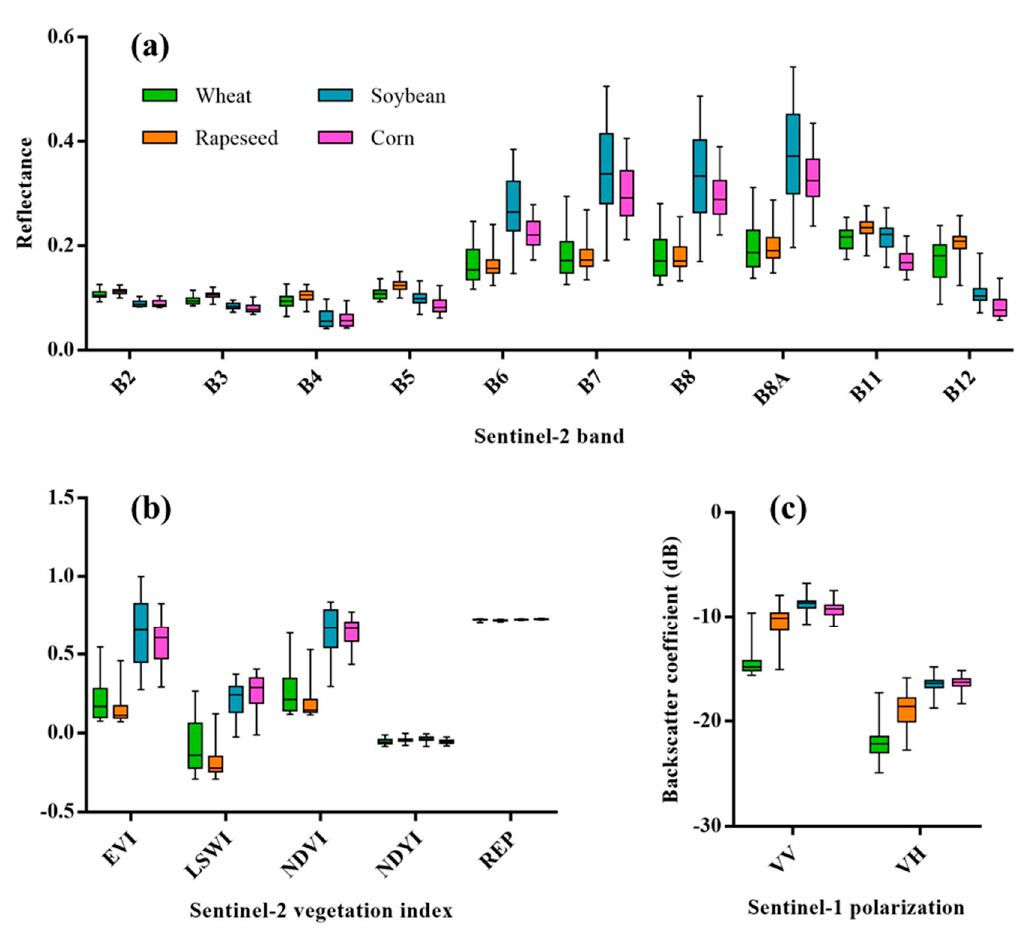
Figure 5. The differences among input features ( a ) Sentinel-2 spectral bands, ( b ) Sentinel-2 vegetation indices, and ( c ) Sentinel-1 polarization bands in crop type mapping. (The REP values in this figure were divided by 1000).